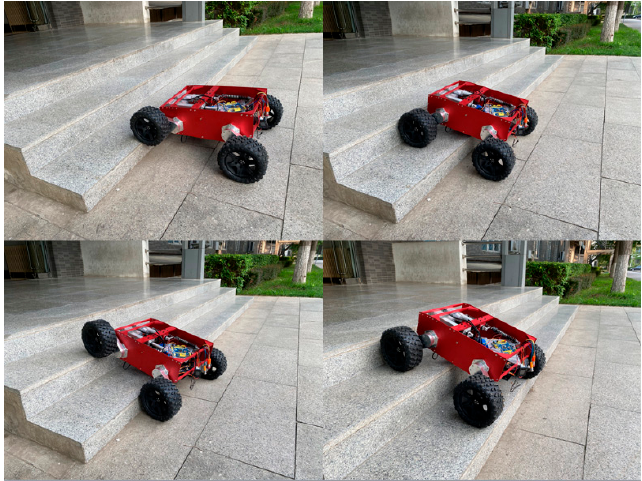
Figure 18. Robot vertical obstacle crossing